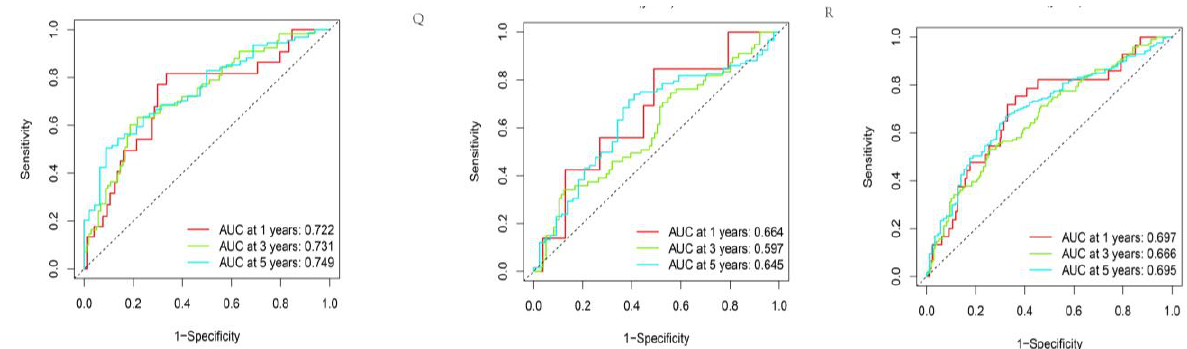
Figure 3. Assessment of prognosis-related protein model for disease-free interval (DFI), disease- specific survival (DSS), and progression-free interval (PFI). ( A ) Kaplan–Meier survival curve for DFI between high- and low-score groups in the training, testing ( B ), and whole ( C ) sets. ( D ) ROC curve for 1-year, 3-year, and 5-year DFI in the training, testing ( E ), and whole ( F ) sets. ( G ) Kaplan–Meier survival curve for DSS between high- and low-score groups in the training, testing ( H ), and whole ( I ) sets. ( J ) ROC curve for 1-year, 3-year, and 5-year DSS in the training, testing ( K ), and whole ( L ) sets. ( M ) Kaplan–Meier survival curve for PFI between high- and low-score groups in the training, testing ( N ), and whole ( O ) sets. ( P ) ROC curve for 1-year, 3-year, and 5-year PFI in the training, testing ( Q ), and whole ( R ) sets.